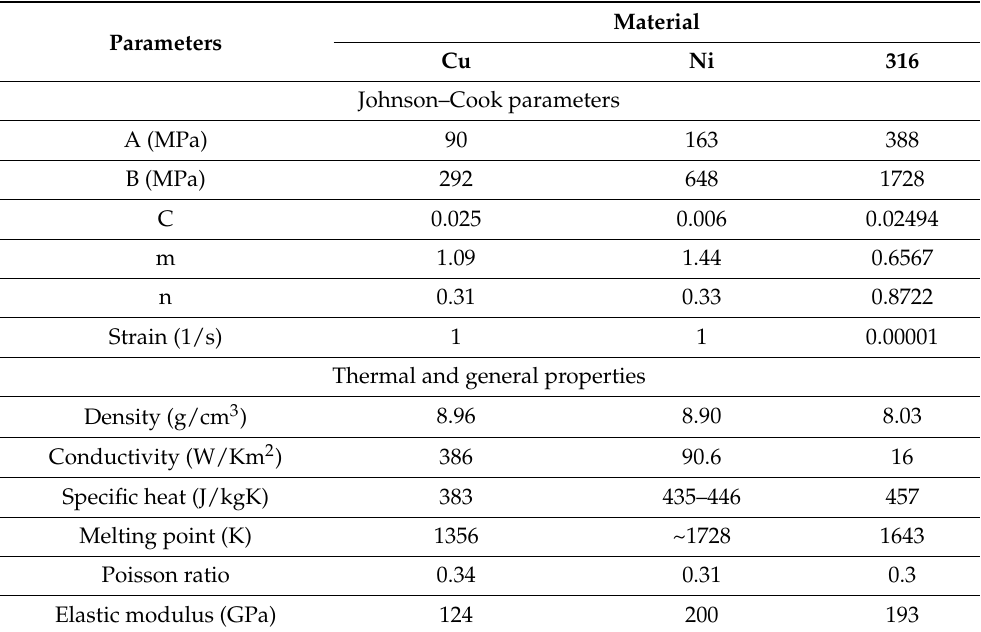
Table 4. Typical JC model and general parameters used for numerical simulation of cold spray for Cu, Ni, and 316SS extracted from published literature [48,86,95–97].